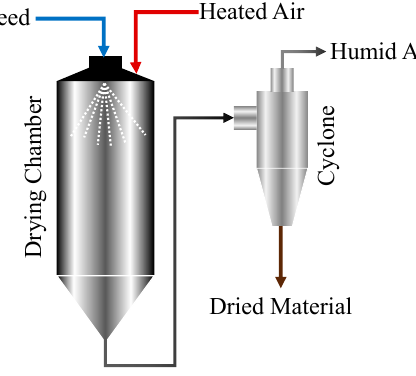
Figure 1. Schematic of spray drying unit.